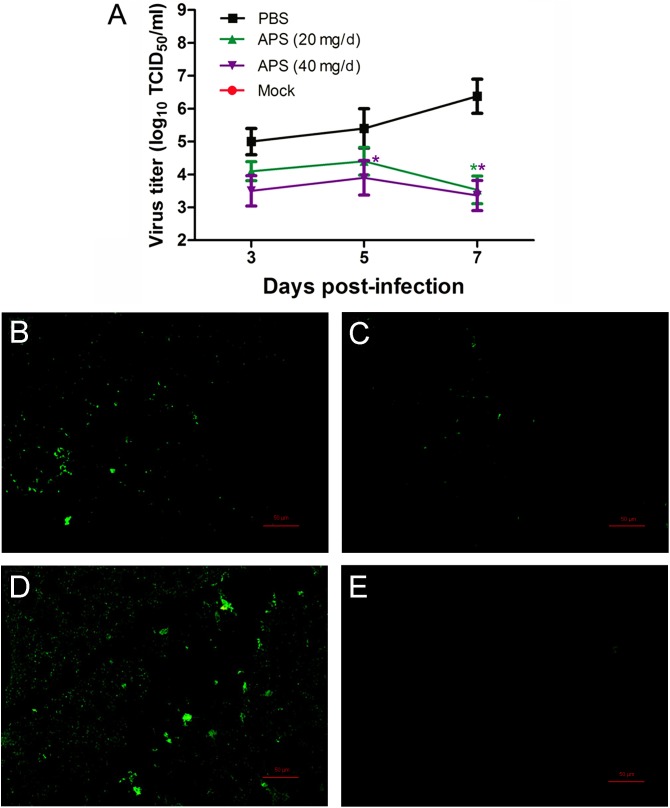
Aloe polysaccharides reduces viral loads in virus-infected mice. All mice in groups I, II, and III were infected intranasally with the 105 TCID50 of virus. Then the mice in groups I and II were orally administrated with 20 and 40 mg of APS per day, respectively, and group III were orally administrated isometric PBS. The virus-free mice in groups IV served as the normal control. The viral titers (A) in lung tissues were determined by TCID50. The viral localization in lung tissues sections was also performed through immunofluorescence histochemical staining using the mouse anti-influenza NP monoclonal antibody (200×; B, group I; C, group II; D, group III; E, group IV). Scale bar, 50 μm. An asterisk indicates that the value of the corresponding group was significantly different from that of the group III (P < 0.05).